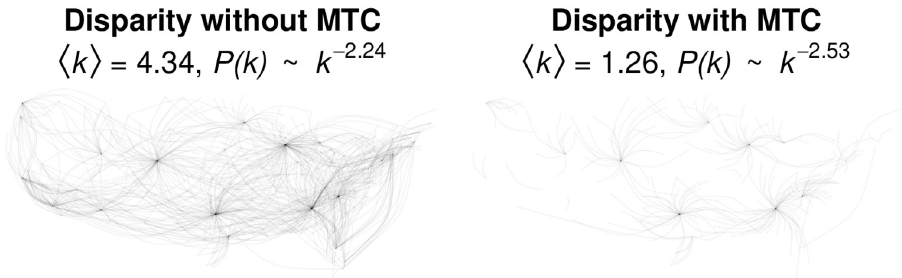
Fig 10. Disparity filter backbone of a weighted network of continental US airline traffic in 2019 at a edgewise error rate (left) or familywise error rate (right) of α = 0.001.